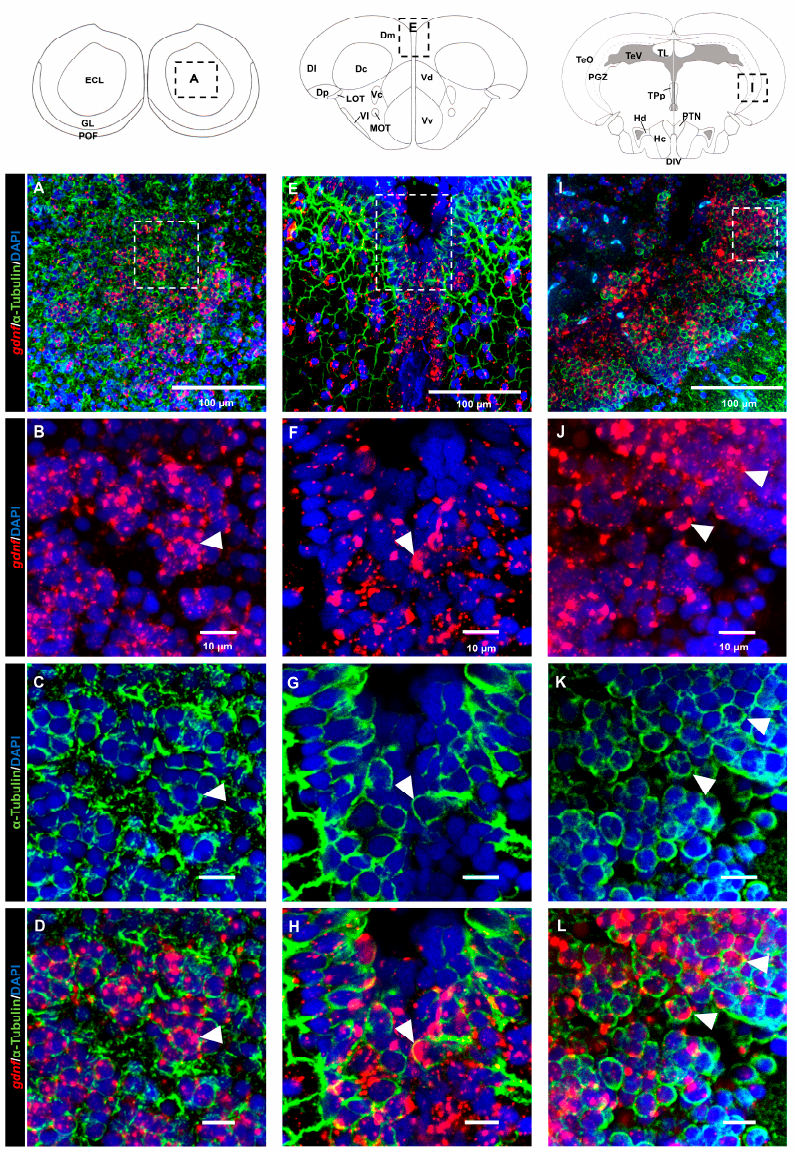
Figure 6. The mature neuronal marker acetylated α -tubulin is co-expressed with gdnf transcripts. Co-expression of gdnf and acetylated tubulin is detected in ( A – D ) olfactory bulb (OB), ( E – H ) medial zone of the dorsal telencephalon area (Dm), and ( I – L ) periventricular gray zone (PGZ) of optic tectum. Black dashes in the graphical illustrations outline the regions of interest. White dashes outline the respective magnified regions that were constructed from selected z-stacks. The white arrowheads indicate the co-expression of gdnf and acetylated α -tubulin. Abbreviations: ECL: External cellular layer of olfactory bulb including mitral cells; GL: Glomerular layer of olfactory bulb; POF: Primary olfactory fiber layer; D: Dorsal telencephalic area; Dc: Central zone of dorsal telencephalic area; DI: later zone of dorsal telencephalic area; Dm: Medial zone of dorsal telencephalic area; Dp: Posterior zone of dorsal telencephalic area; LOT: Lateral olfactory tract; MOT: Medial olfactory tract; Vc: Central nucleus of ventral telencephalic area; Vd: Dorsal nucleus of ventral telencephalic area; VI: Lateral nucleus of ventral telencephalic area; Vv: Ventral nucleus of ventral telencephalic area; DIV: Diencephalic ventricle; Hc: Caudal zone of periventricular hypothalamus; Hd: Dorsal zone of periventricular hypothalamus; PGZ: Periventricular gray zone of optic tectum; PTN: Posterior tuberal nucleus; TeO: Tectum opticum; TeV: Tectal ventricle; TL: Torus longitudinalis; TPp: Periventricular nucleus of posterior